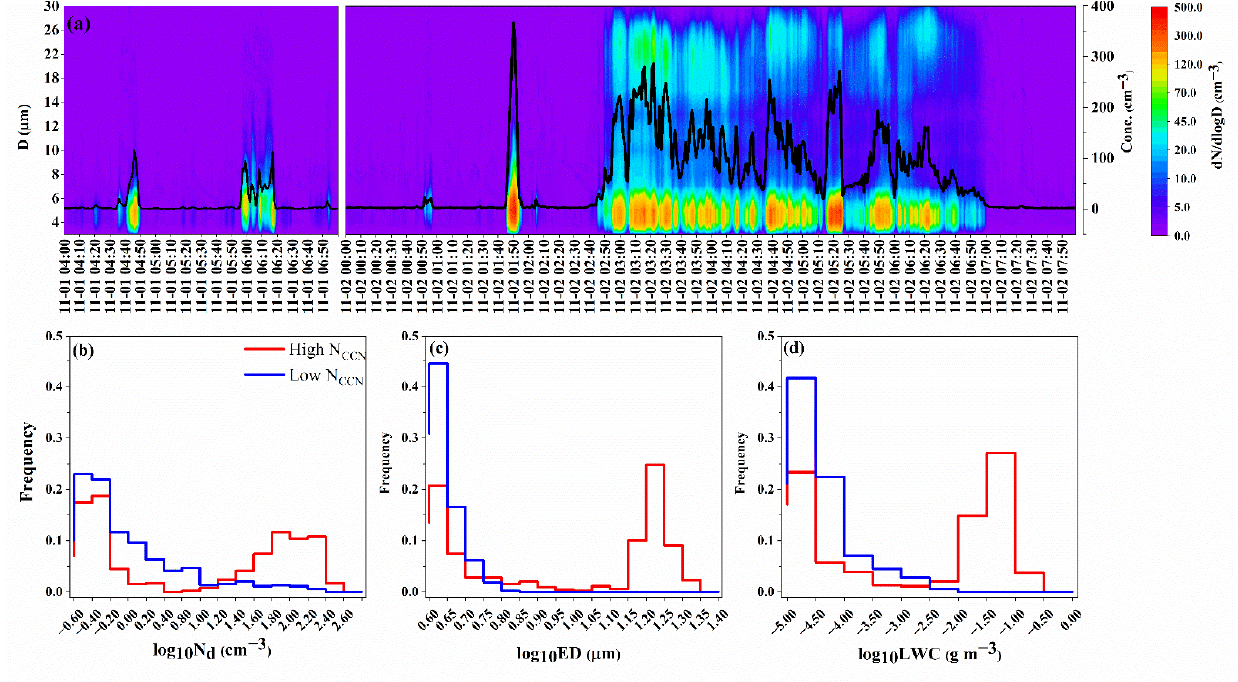
Figure 5. Temporal variations of ( a ) fog droplet concentration and size distribution on 1 and 2 November and ( b – d ) probability distribution of the fog droplet concentration (N d ), equivalent diameter (ED), and liquid water content (LWC) for the high N CCN (>75th percentile) and low N CCN cases (<25th percentile).